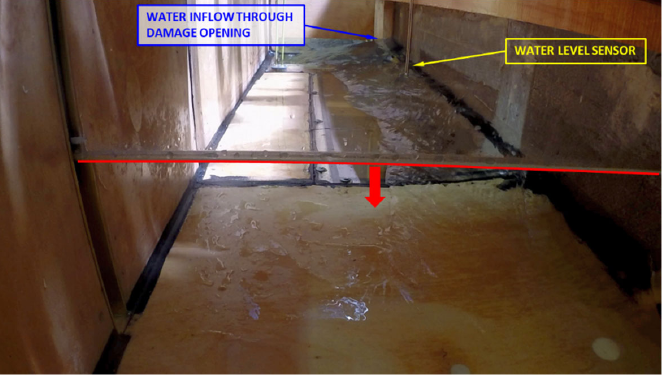
Figure A7. Camera view on the trailer deck. The positions of the damage opening and the water level sensor are indicated with arrows. The red line and arrow show the movement of the watertight barrier made of clear transparent acryl glass.